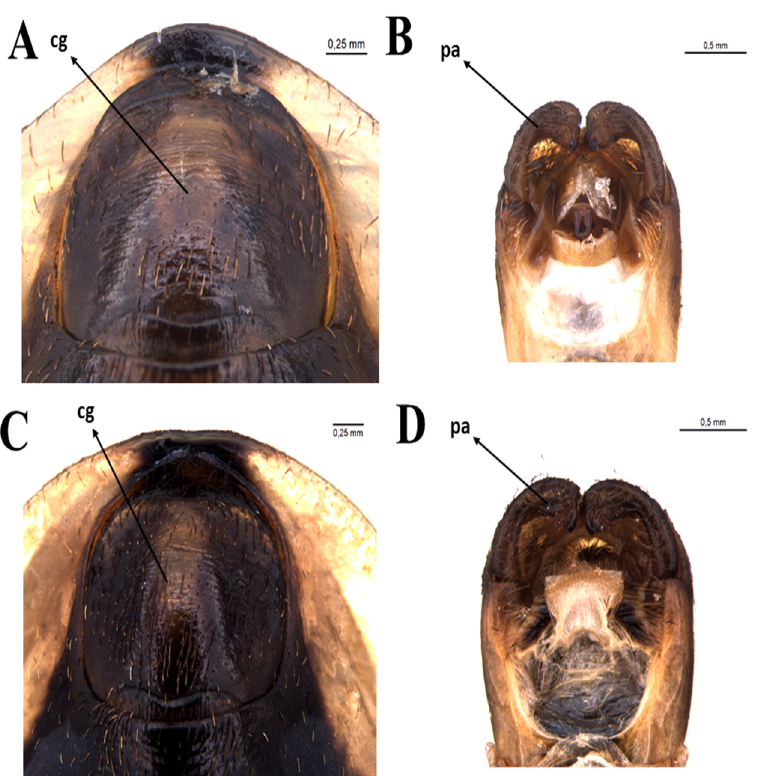
Figure 6. Detail of genital capsule T. rosai sp. nov.: ( A ) dorsal view, ( B ) ventral view, T. sordida : ( C ) dorsal view, ( D ) ventral view. cg: genital capsule, pa: paramere.